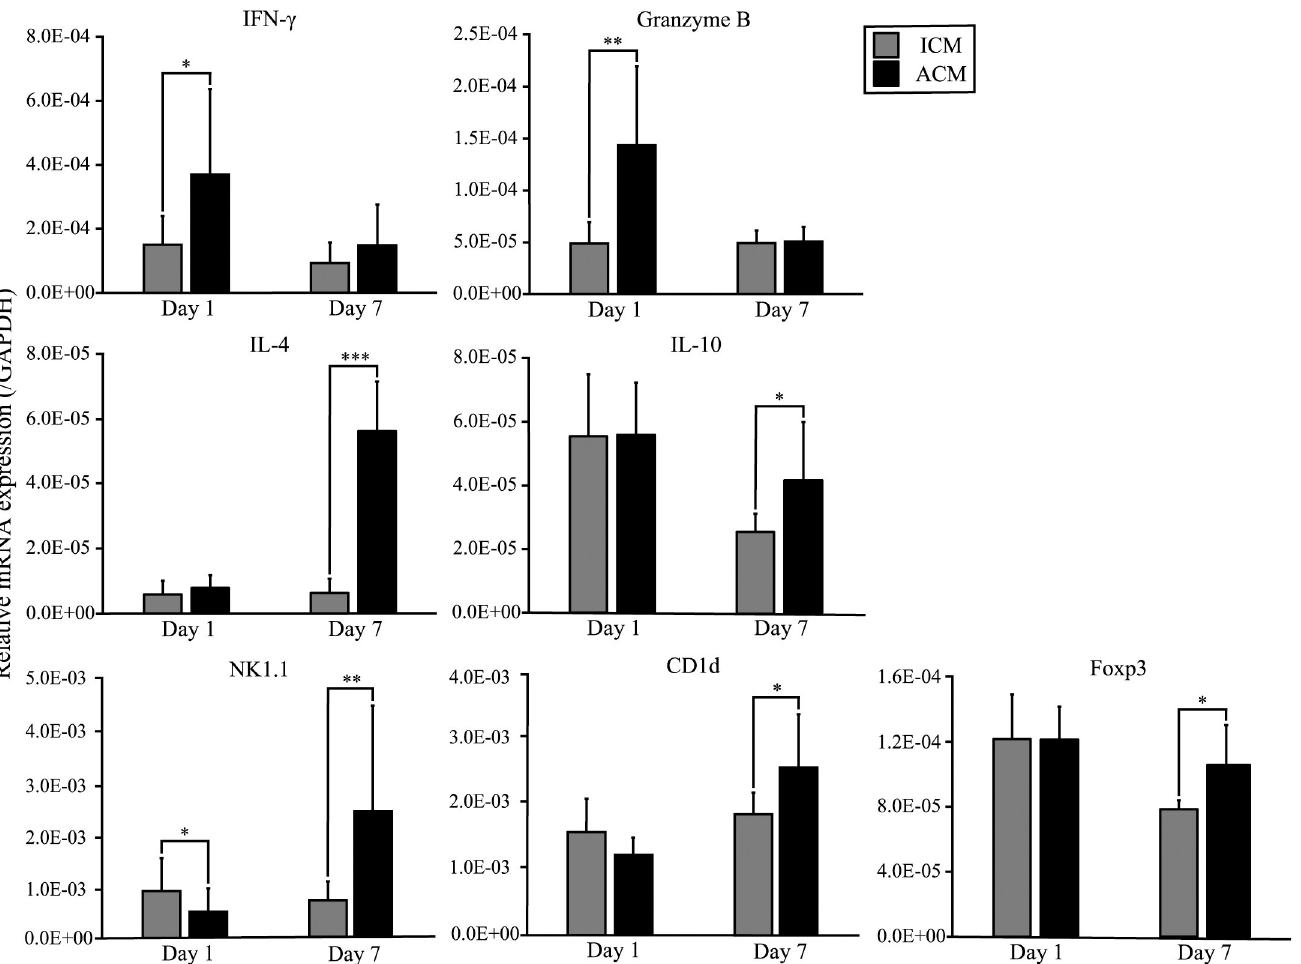
Fig 7. mRNA expression of T cell-related cytokines, cytotoxic granules and Foxp3 in ICM and ACM mice. The mRNA expression levels of IFN- γ , IL-4, IL-10, Granzyme B, NK1.1, CD1d, and Foxp3 in the buccal mucosa were assessed at days 1 and 7 after challenge. GAPDH gene expression was used as an internal control. At day 1 after challenge, the buccal mucosa mRNA levels of IFN- γ and Granzyme B were significantly higher in ACM mice compared with ICM mice. IL-4, NK1.1, CD1d, IL-10, and Foxp3 levels were significantly higher in ACM mice compared with ICM mice at day 7 after challenge. Bars and error bars indicate the mean plus standard deviation. Statistical significance was tested by the Mann–Whitney U- test ( � p < 0.05, �� p < 0.01, ��� p < 0.001).